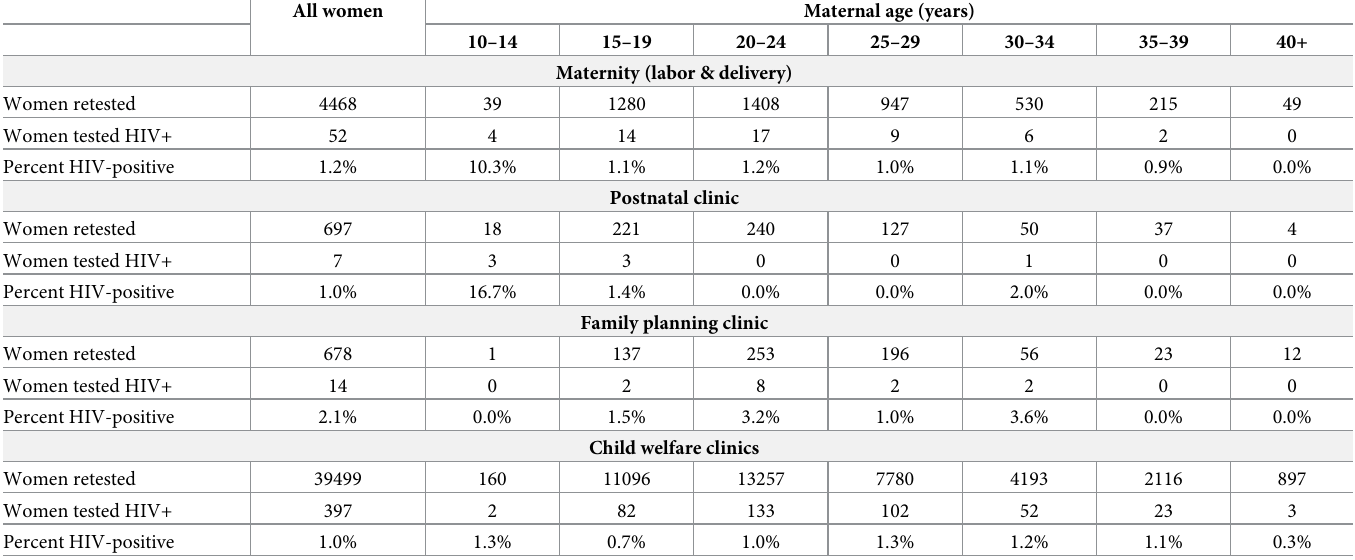
Table 1. Women retested in maternity, postnatal, family planning and child welfare clinics and proportion HIV-positive by age, Nampula, Mozambique, April- November